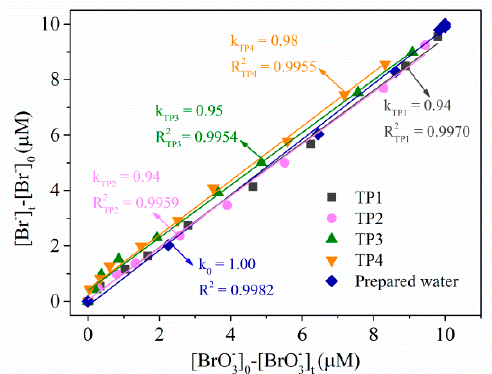
Figure 6. Transformation products analysis of BrO − in prepared water and four tap waters using the UV/sulfite/I − process. Conditions: [BrO − ] 0 = 10 μ M, [ I (cid:2879) ] 0 = 100 μ M, [sulfite] 0 = 1.0 mM, [DO] 0 = 7.0 mg · L − 1 , pH = 9.2, 20 ± 1 °C.